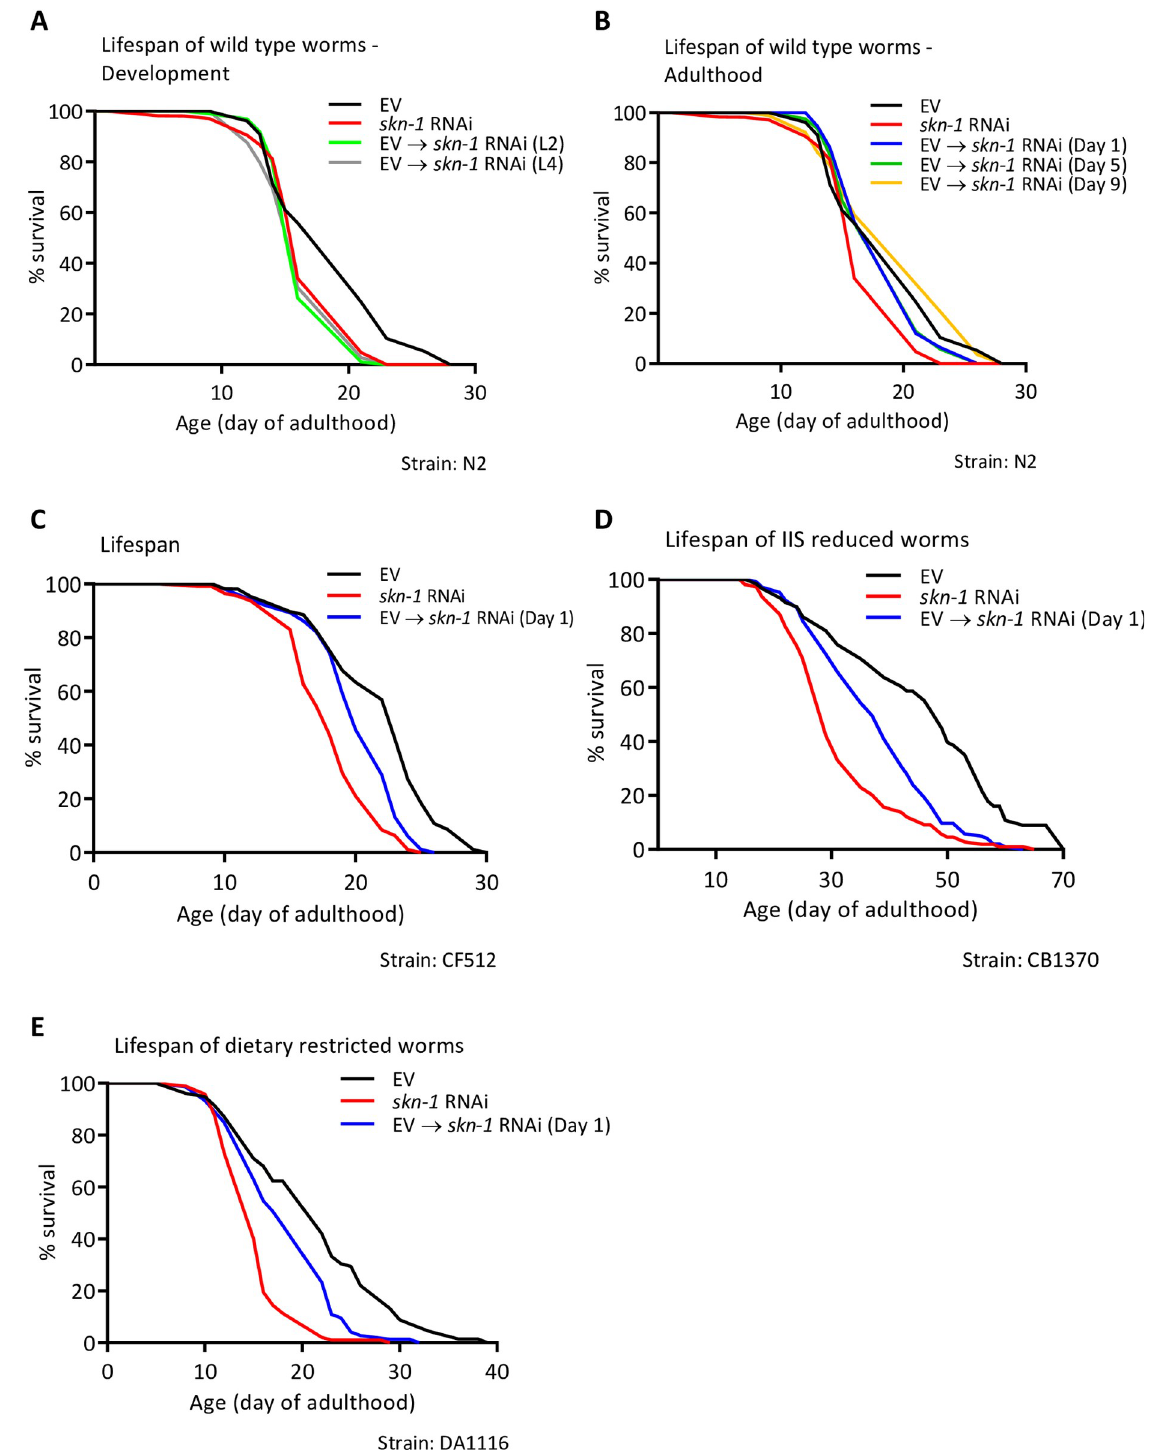
Fig 1. skn-1 regulates lifespan primarily from late larval development through early adulthood. ( A-B ) The lifespan of wild type animals (WT, strain N2) treated from hatching with empty vector bacteria (EV, control), skn-1 RNAi, or transferred from EV bacteria onto skn-1 RNAi either during developmental stages L2 or L4 (A), or at day 1, 5, or 9 of adulthood (B) was measured. Worms treated with skn-1 RNAi throughout life, or during developmental stages L2 or L4 showed significant reductions in lifespan (10.75%, 11.80%, and 14.23%, respectively, S1 Table). Worms treated with skn-1 RNAi from day 1 or 5 of adulthood showed a trend of reduction in lifespan, though the observed